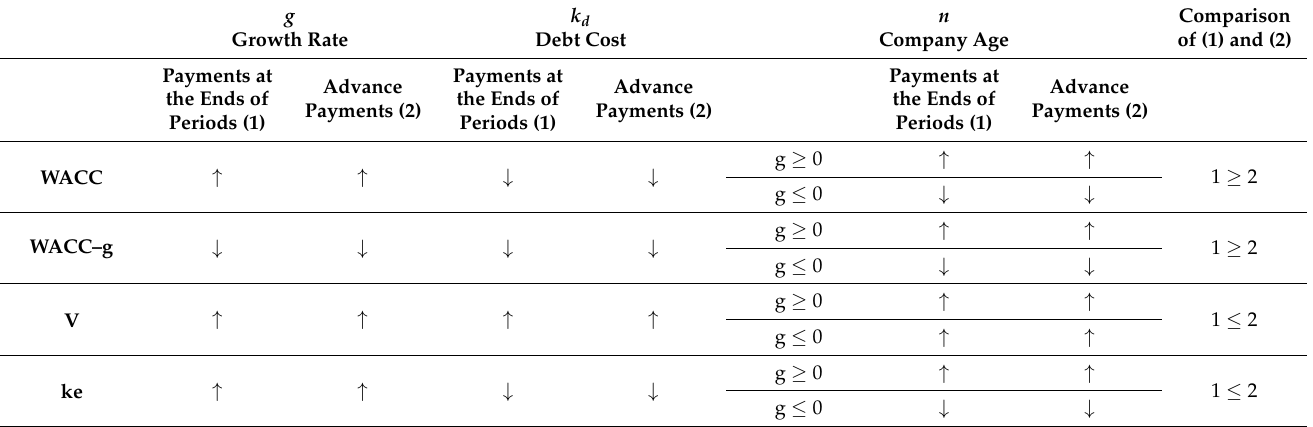
Table 1. Comparison of the results in GBFO theory with payments of tax on profit at the end of periods (1) and advance payments (2) for parameters g (growth rate), k d (debt cost), and n (company age (for five-year and ten-year companies)) ( ↑ means an increase in the indicator with the current parameter; ↓ means a decrease in the indicator with the current parameter). n g k d Comparison Debt Cost Company Age of (1) and Growth Rate